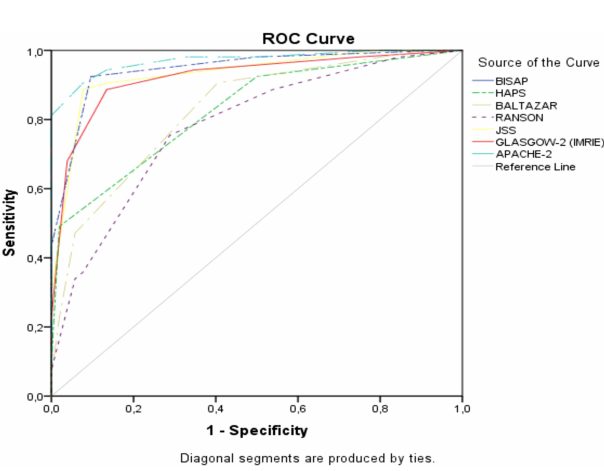
Figure 1. Receiver operating curves (ROC) for scoring systems of acute